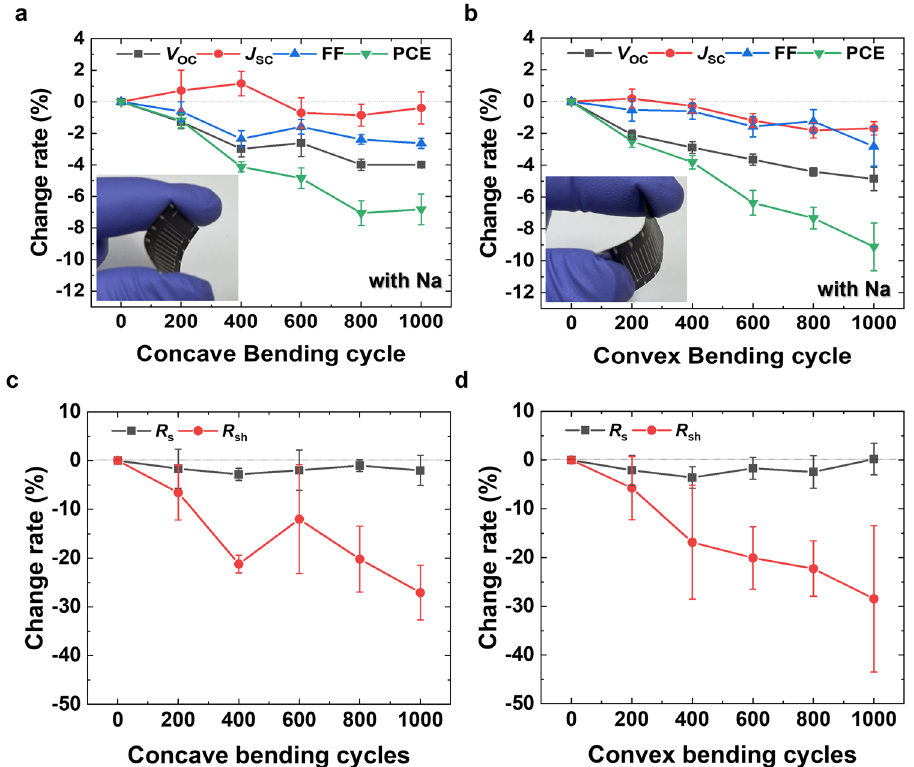
Fig. 4 Changes in photovoltaic device parameter by mechanical bending test. a , b Rate of change of photovoltaic device parameters with concave ( a ) and convex ( b ) bending with a bending radius of 50 mm and a maximum of 1000 bending cycles. Photovoltaic device parameters were measured after 200, 400, 600, 800, and 1000 bending cycles. The inset in ( a , b ) shows an image of the bent device. c , d Rate of change of series and shunt resistance with concave ( c ) and convex ( d ) bending with the same bending condition. Error bars in ( a – d ) are de fi ned as standard deviation of photovoltaic parameters obtained from four points of two